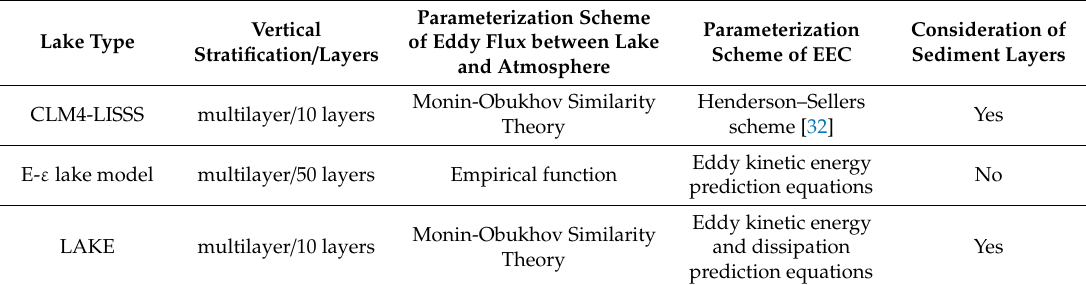
Table 1. Comparison of physical processes in three lake